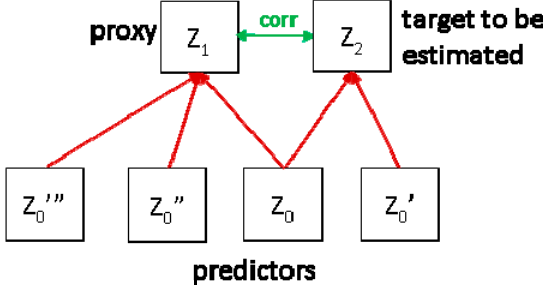
Figure 3. Physical predictors and proxies (see text).